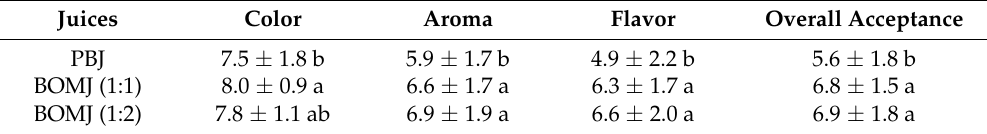
Table 5. Acceptance of the